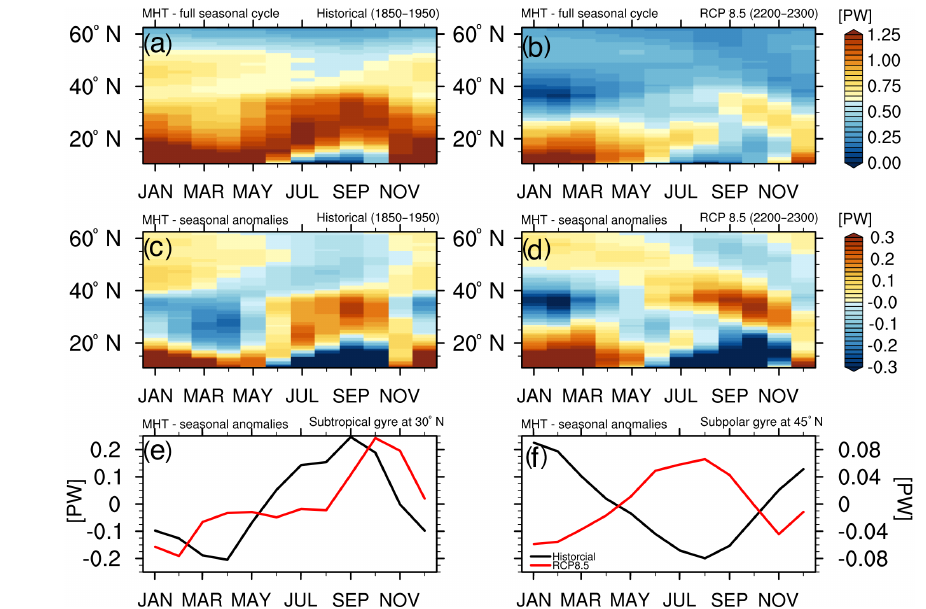
Figure 6. The Atlantic meridional heat transport seasonal cycle (in PW) in the historical simulation (1850–1950, (a) and (c) ) and RCP 8.5 (2200–2300, (b) and (d) ). The OHT seasonal cycle in the historical simulation (1850–1950, black) and RCP 8.5 (2200–2300, red) (e) at 30 ◦ N in the subtropical gyre and (f) at 45 ◦ N in the subpolar gyre. (a) and (b) show the full seasonal cycle and (c) – (f) show anomalies relative to the annual mean at every latitude. Colour interval in (a) – (d) is 0.02PW.